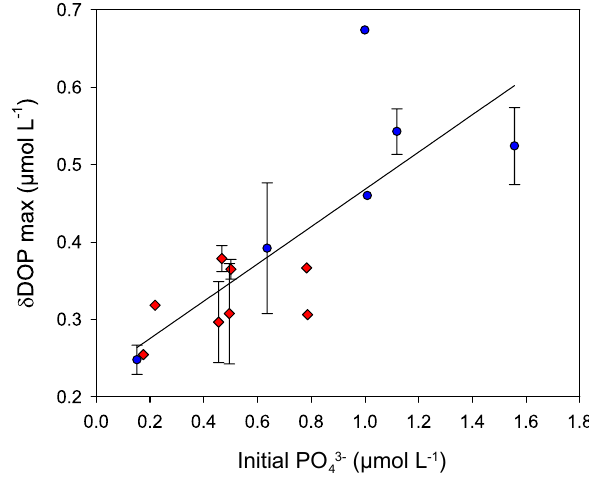
Figure 6. Positive linear correlation between maximum DOP ac- cumulation (defined as peak DOP concentration subtracted by the initial DOP concentration) and initial PO 3 − (blue circles) and varied N (red